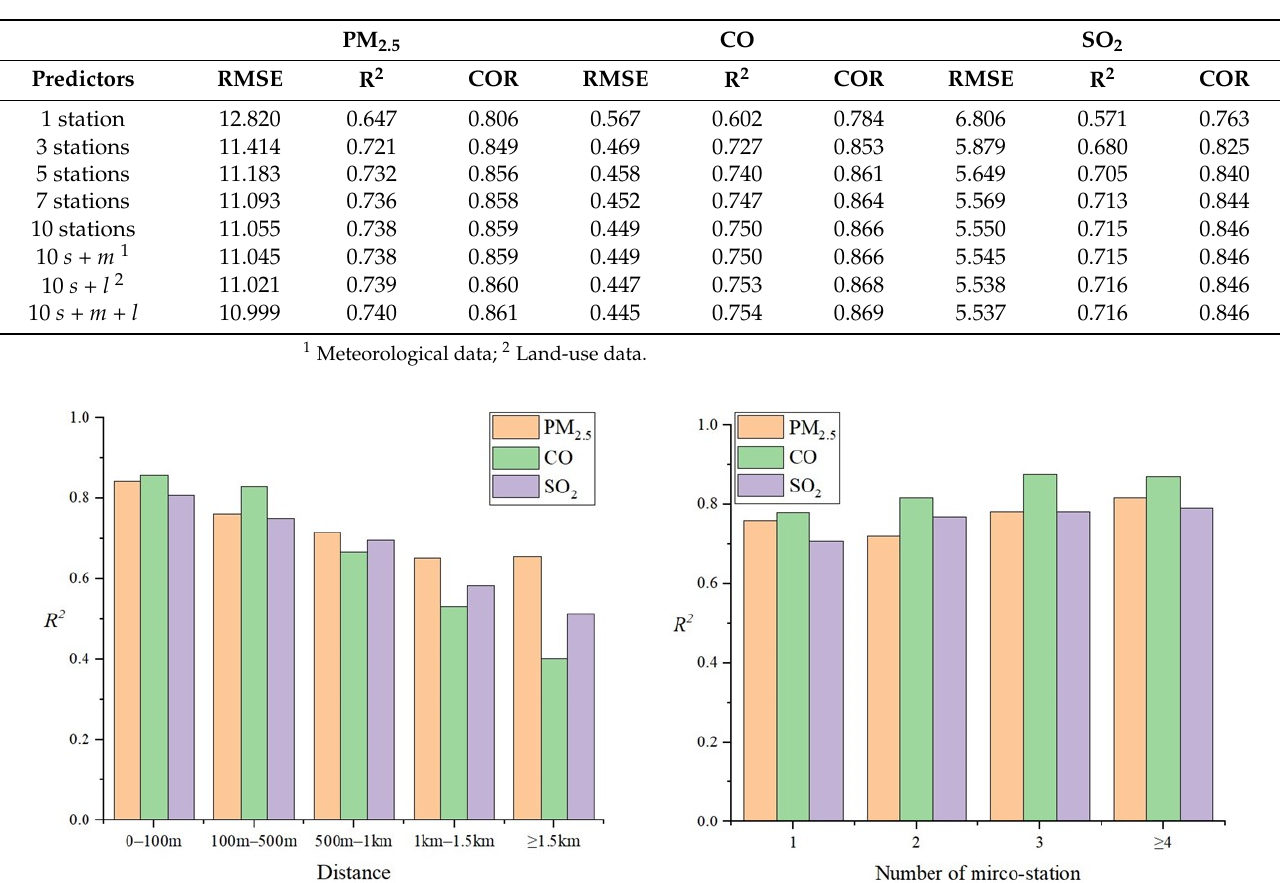
Table 3. The impact of different predictors on the XGBoost model performance.